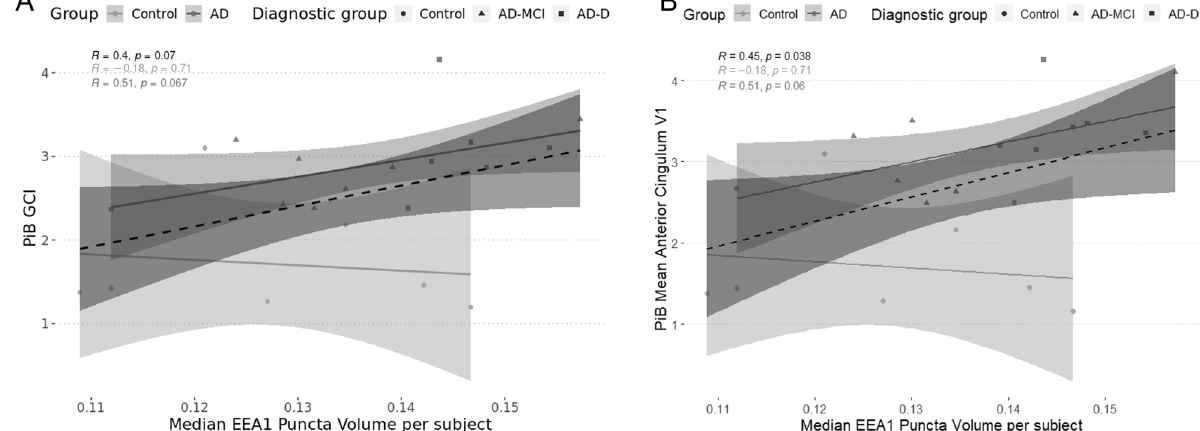
Fig. 4 Graphical representations of the correlations between PiB retention and the median EEA1 positive puncta volume. For all cases, circles represent controls, triangles represent AD-MCI, and squares represent AD-D. Likewise, the total correlation is represented as a dashed line in dark-grey and its 95% con fi dence interval is represented in the shaded dark grey area. The strati fi ed correlations according to disease group are in grey (AD) and light grey (Control). Correlation values are on the graph, with the total correlation being in black, the correlation for controls in light grey, and the correlations for AD in dark grey. A shows correlations between global PiB retention and EEA1 positive puncta volume, B presents correlations between PiB retention in the anterior cingulum and EEA1 positive puncta